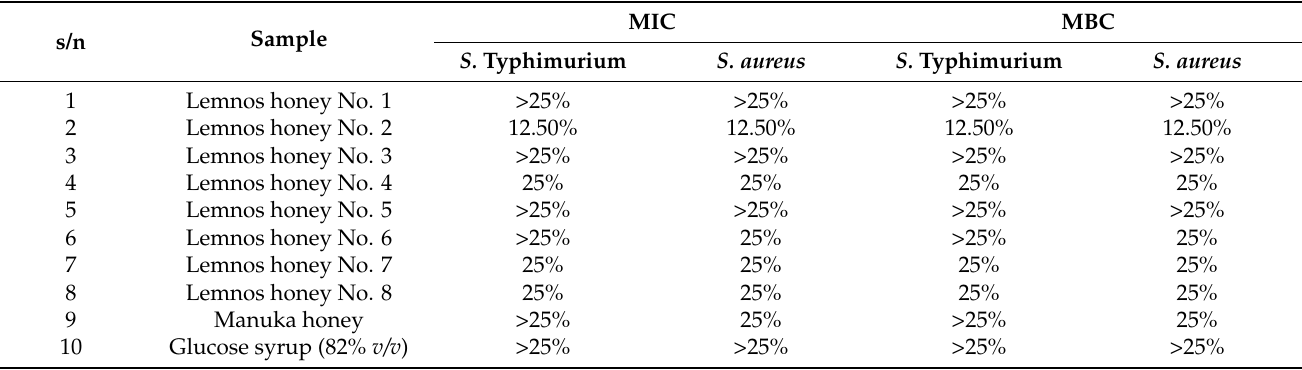
Table 2. MIC and MBC of each honey against S . Typhimurium and S. aureus as determined by the broth microdilution and agar spot methods. The MIC and MBC of glucose syrup (82% v/v ) used as a negative antimicrobial control are also indicated.